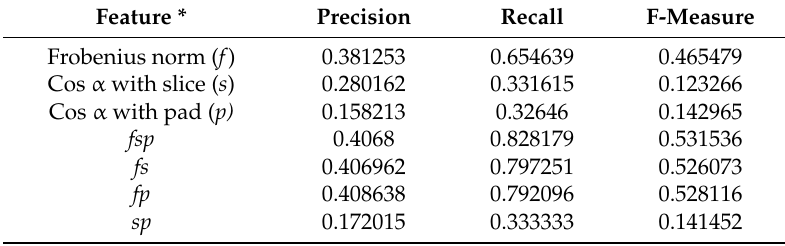
Table 3. Results of various features using the Frobenius norm ( f ), Cos α with slice ( s ), and Cos α with pad ( p